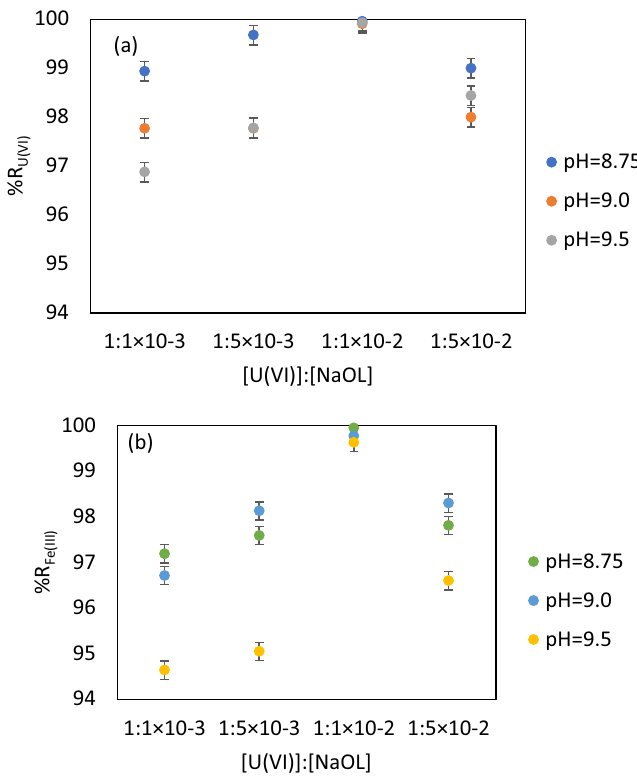
Figure 5. ( a ) %R U(VI) = f([U(VI)] : [NaOL]) in the optimal pH range; ( b ) %R Fe(III) = f([U(VI)] : [NaOL]) in the optimal pH range